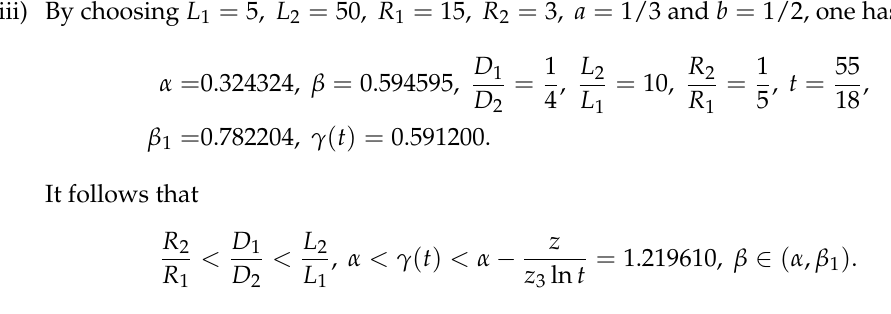
Figure 3. Identification of critical potentials V 2 , V 3 and V 1 c and approximation of J 1 (cid:110) (cid:111) D 1 L 2 < min , R 2 for ε = D 2 L 1 R 1